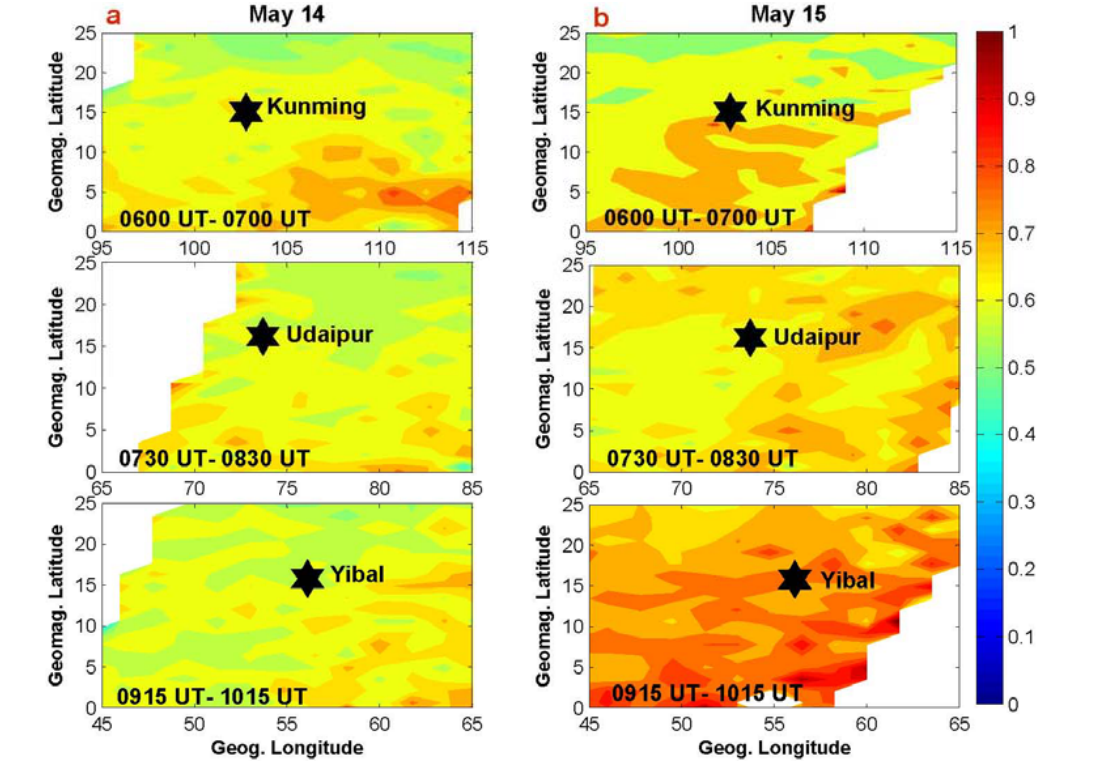
Fig. 3. Variation of [O/N 2 ] on 14 May, an international geomagnetic quiet day (panel a ) and on 15 May, the storm day (panel b ) over a wide range of (magnetic) latitudes and longitudes. The UT hours shown in each panel correspond to the passage time of a satellite over the longitudes of the abscissa. The chosen GPS stations have been marked as a star in each panel. Large enhancements in [O/N 2 ] ratio on 15 May for longitude belt 45 ◦ –65 ◦ E (bottom right panel) corresponding to the period 09:15UT to 10:15UT are clearly